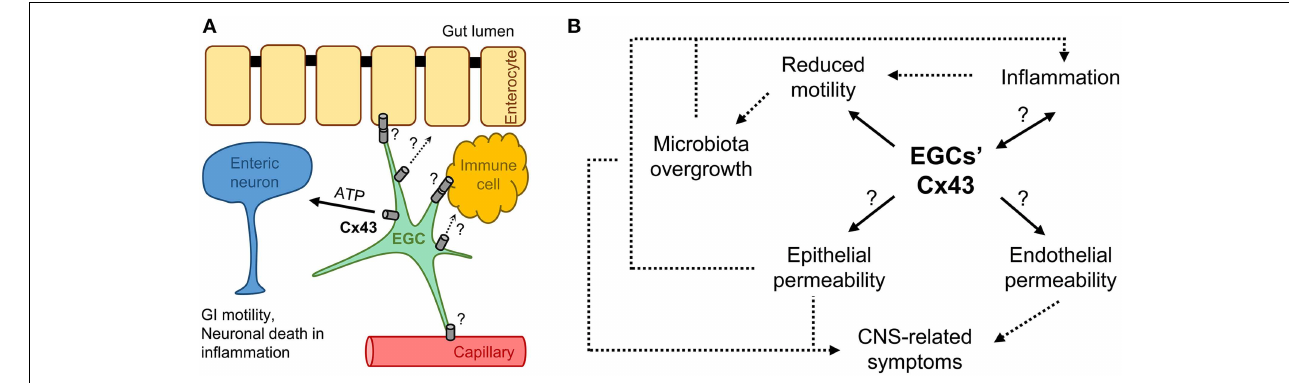
FIGURE 1 | Is Cx43 on enteric glia involved in autism spectrum disorder (ASD)? (A) Enteric glial cells (EGCs) interact with enteric neurons within the enteric nervous system and other cells in the gut wall, such as enterocytes, vasculature endothelial and immune cells, regulating gastrointestinal (GI) motility, as well as epithelial/endothelial barriers and inflammation in the intestine; these interactions could happen through cell-to-cell coupling via Cx43 gap junctions or factors released through Cx43 hemichannels. (B) Possible roles for EGCs’ Cx43 in the vicious cycle of GI